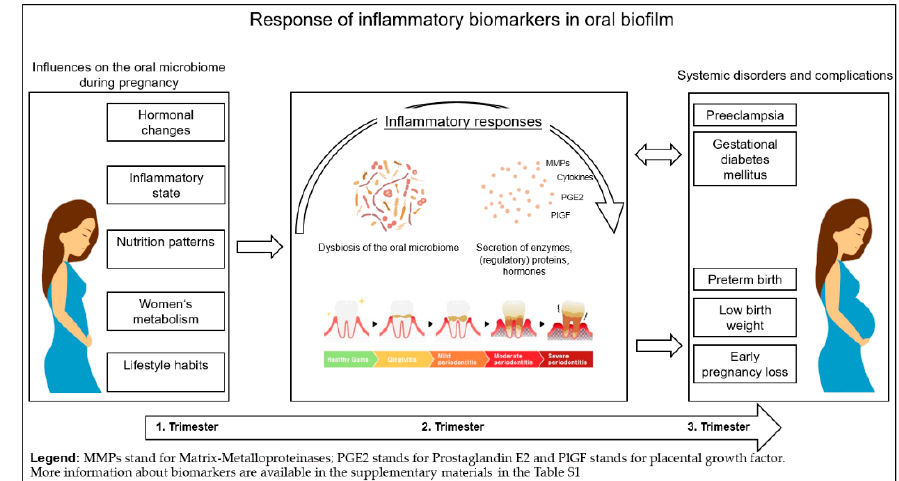
Figure 1. Response of inflammatory biomarkers in oral biofilm.